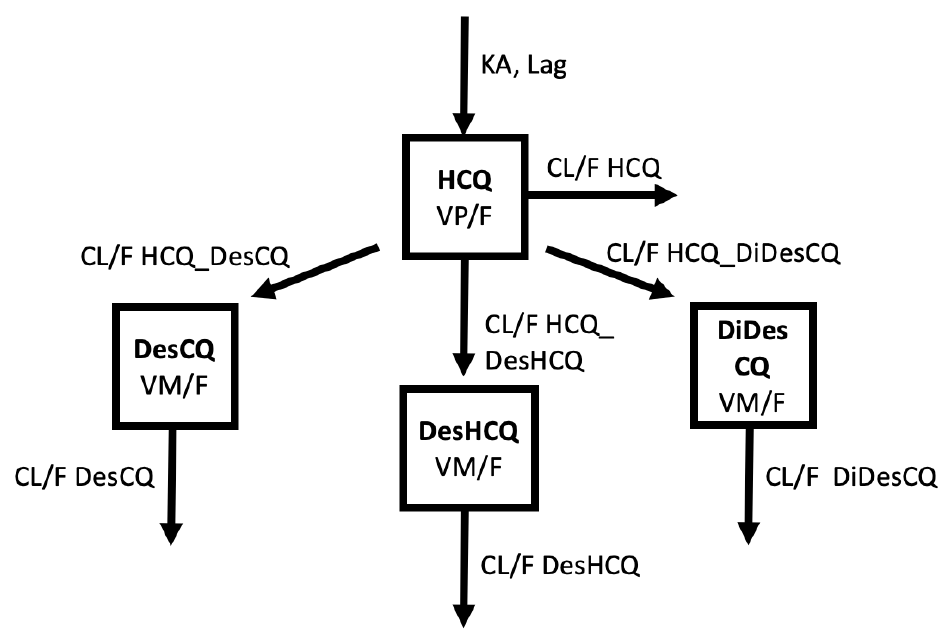
Figure 3. Description of the pharmacokinetic model used to describe HCQ, DesHCQ, DesCQ, and DiDesCQ concentrations.